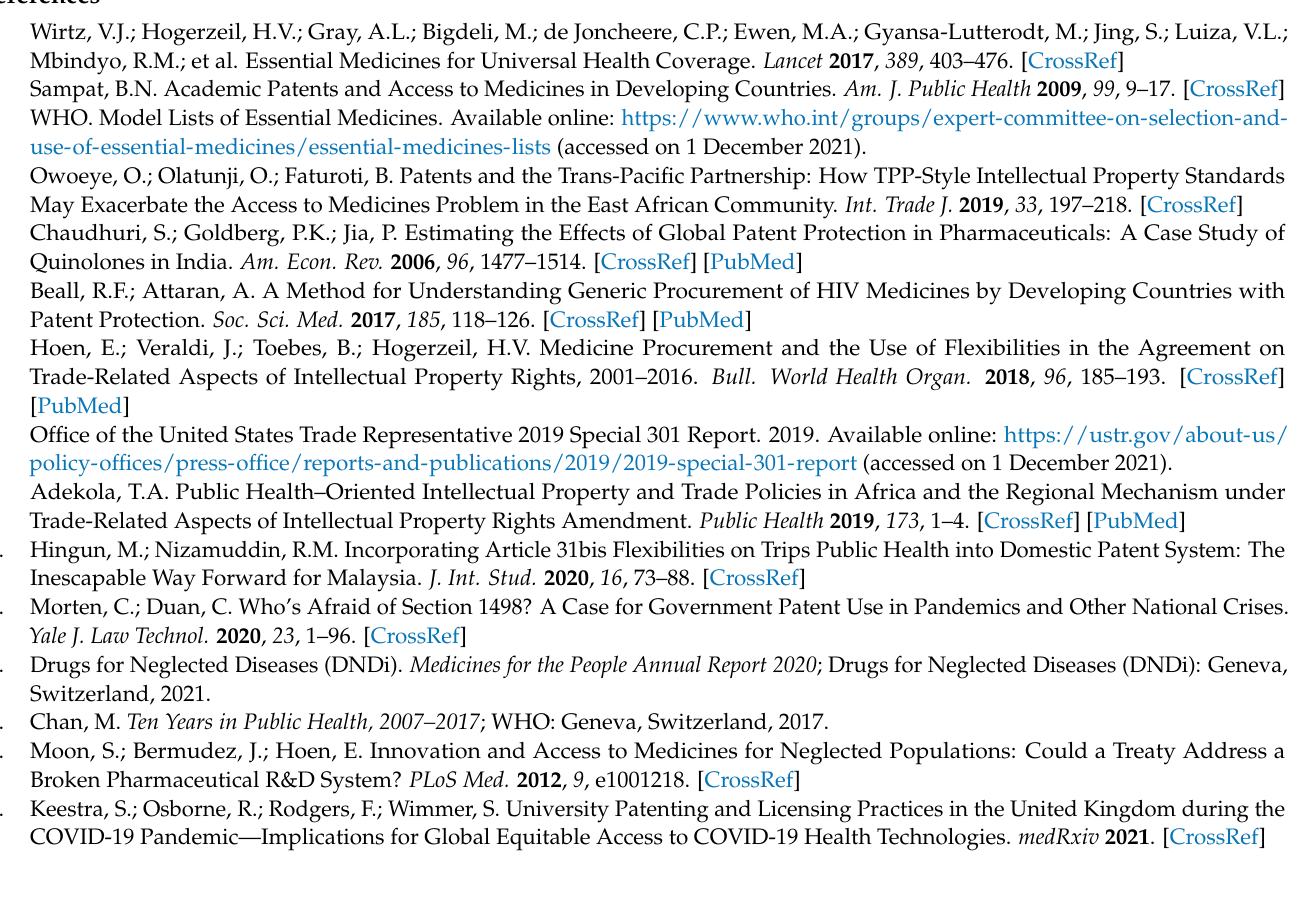
Table S2: List of excluded full-text articles and reasons for